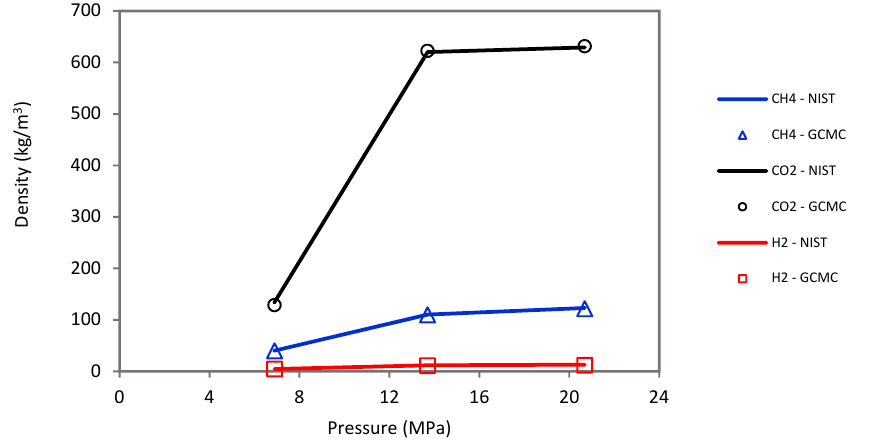
Figure 9. Molecular loading approach shows an acceptable density match between empty cell yields and experimental NIST data for CO 2 , CH 4 , and H 2.